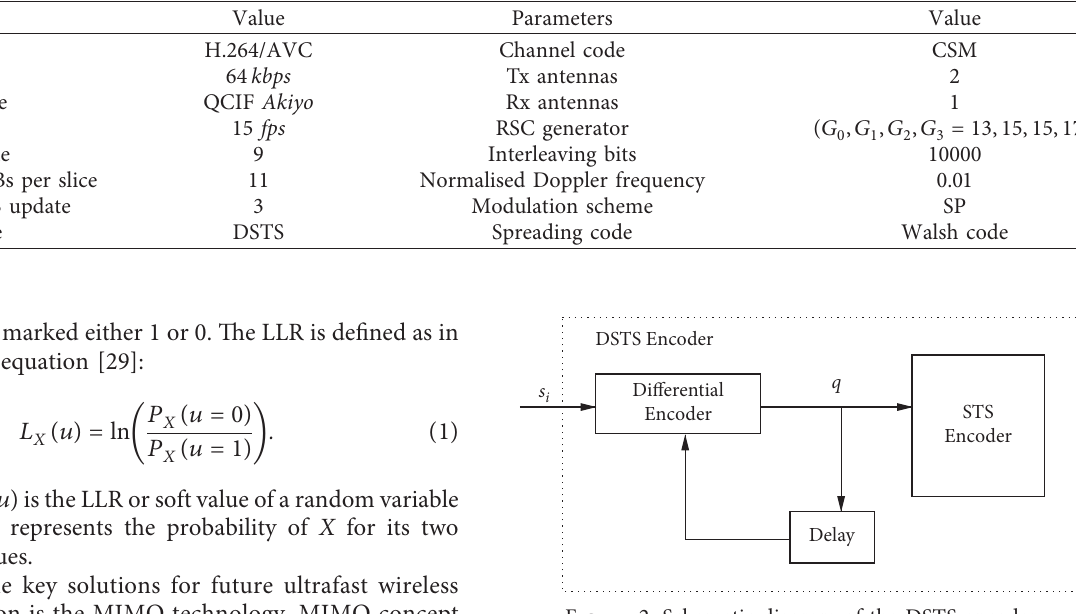
Figure 2: Schematic diagram of the DSTS